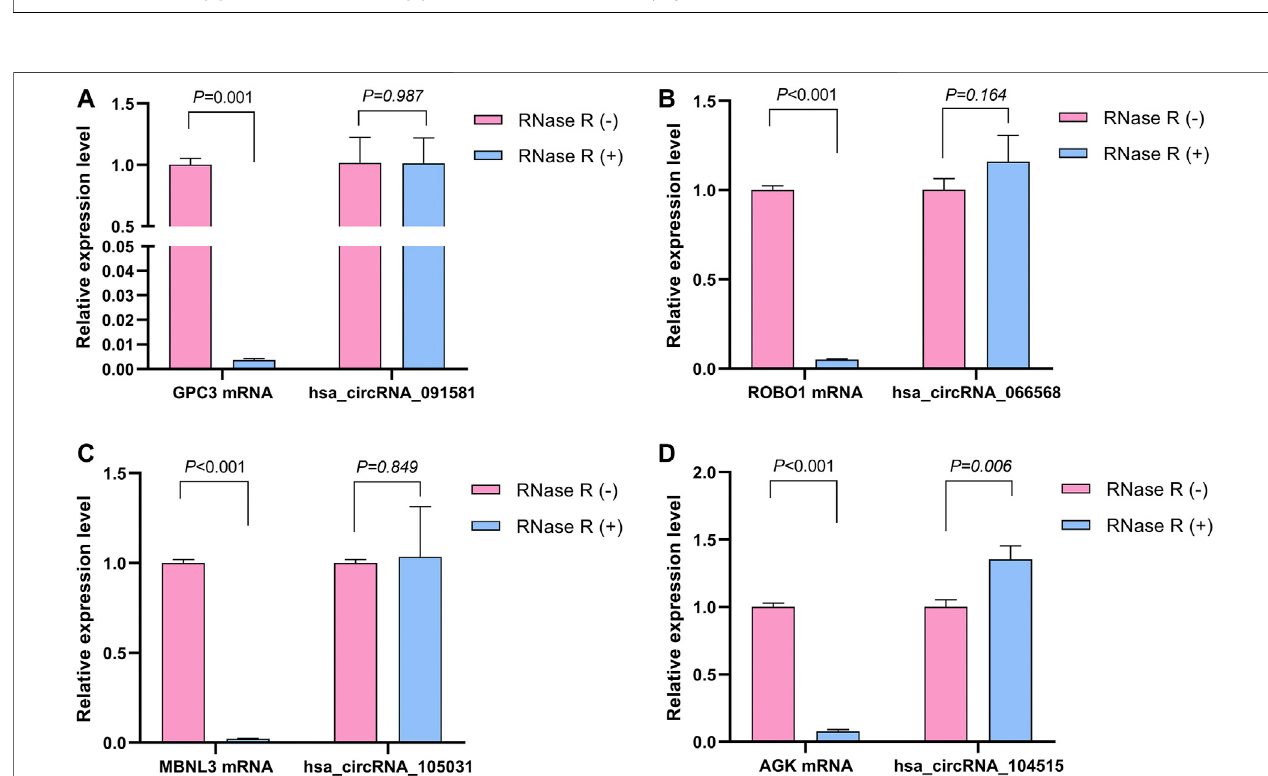
FIGURE6| TherelativeexpressionlevelsofthefourcircRNAsandtheircorrespondinghostgenesundertheRNaseRtreatmentornot. (A) hsa_circRNA_091581. (B) hsa_circRNA_066568. (C) hsa_circRNA_105031. (D) hsa_circRNA_104515.